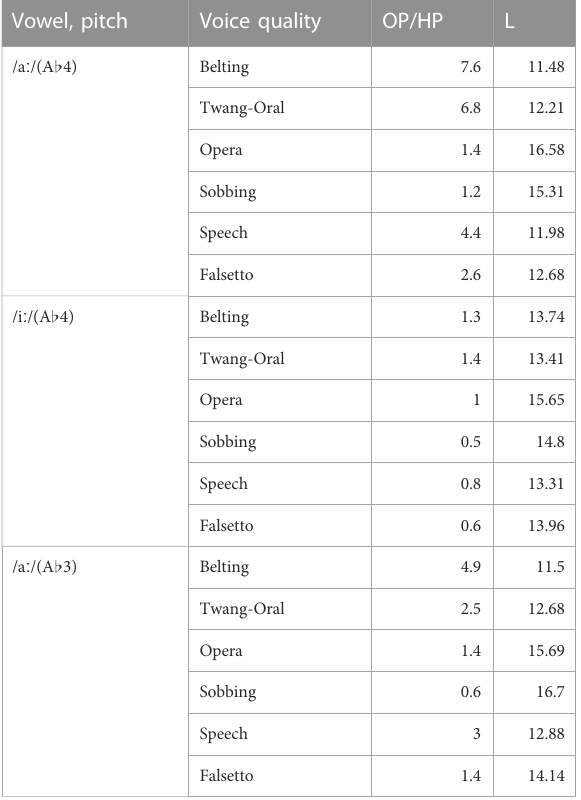
TABLE 1 Dimensionless OP/HP-ratio (Oropharynx/Hypopharynx) and vocal tract length L in cm, for all investigated voice qualities, vowels, and pitch